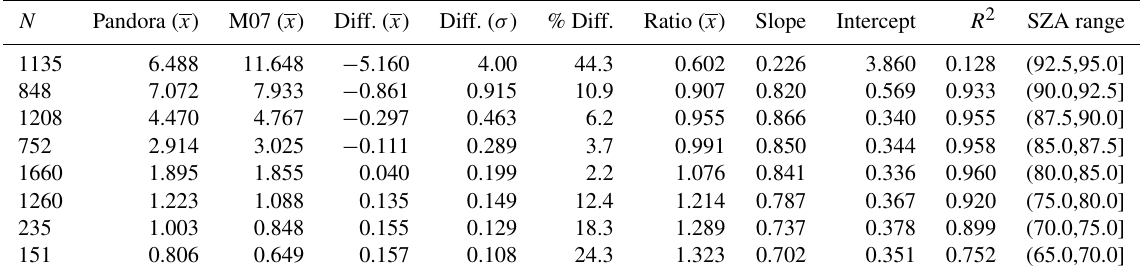
Table 3. Summary of aggregate statistics for the Pandora–NIWA intercomparison using the standard algorithms and parameters for each instrument. Differences and ratios are relative to the NIWA instrument (i.e., Pandora − M07, Pandora/M07). Statistics were generated using data that were resampled to 5min means; no further smoothing or binning was applied. N Pandora ( x ) M07 ( x )